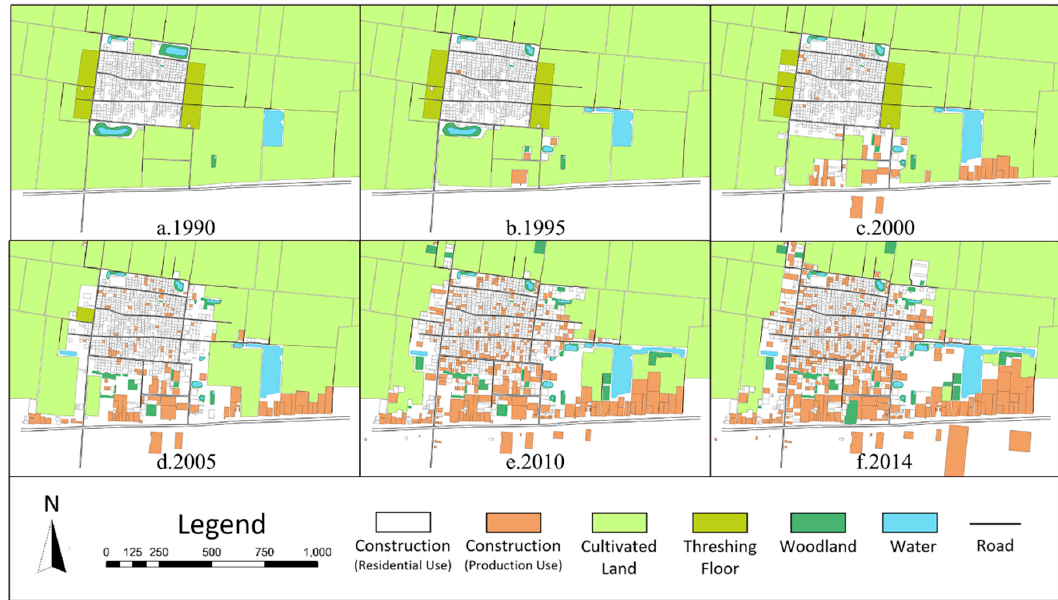
Figure 4. The de facto function of construction land in Fengzhuang, with the manufacturing of mahogany furniture becoming the dominant industry.